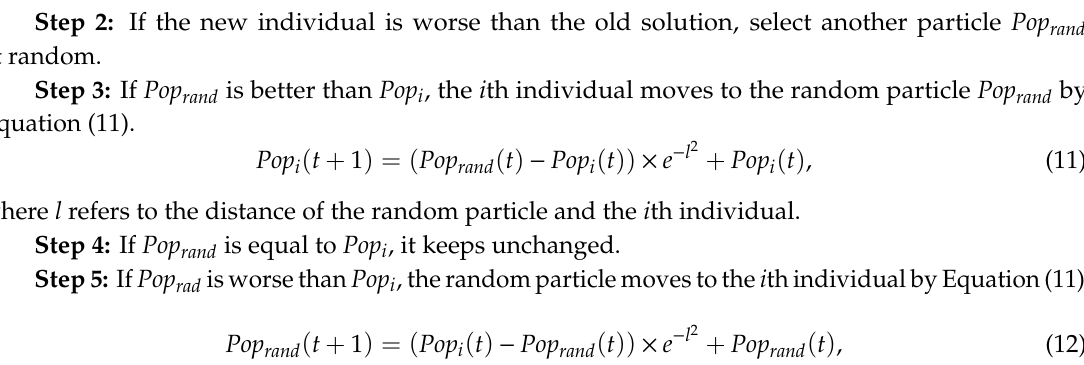
Figure 2. 2D and 3D position vectors and their succeeding possible positions.